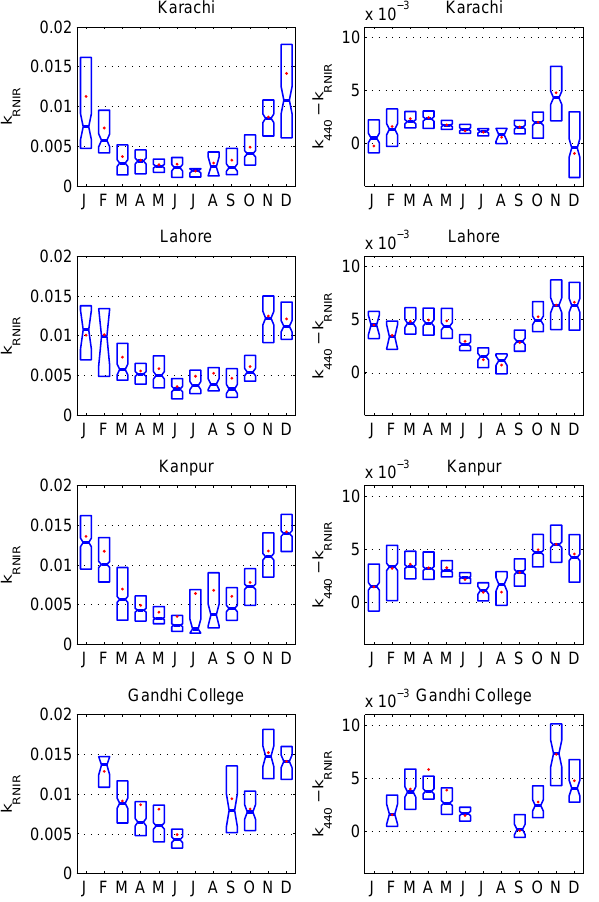
Figure 3. Boxplot of monthly imaginary indices: average of the imaginary index at 670, 870, and 1020nm ( k RNIR ) in the left panel; difference between the imaginary index at 440nm and k RNIR in the right panel, showing the 25 and 75% percentiles. The boxplot indi- cating the median and mean is additionally shown by red dots.